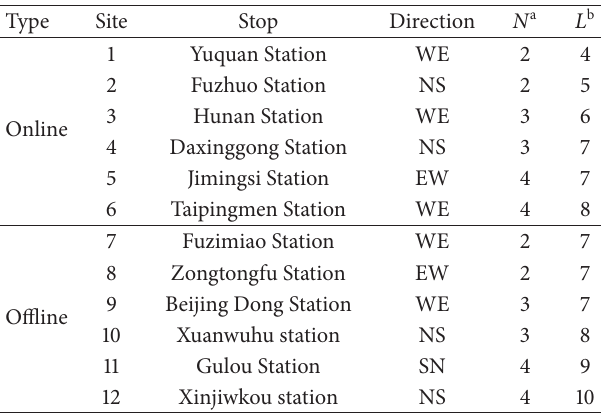
Table 1: Selected bus stops to collect field data.